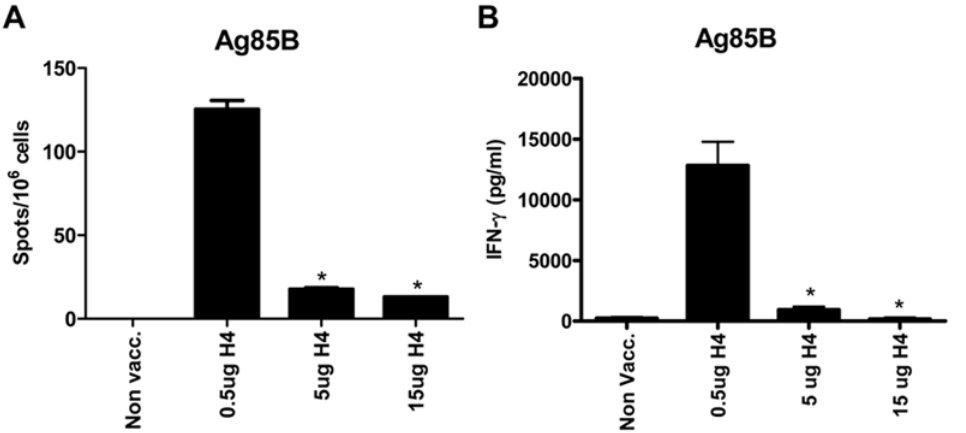
Figure 2. ELISPOT analysis of splenocytes from vaccinated animals. (A and B) Splenocytes isolated from groups of mice vaccinated with 3 different doses of Ag85B-TB10.4 in IC31 H or a saline control group (Non Vacc.) were stimulated in vitro with Ag85B for 48 hours and subjected to ELISPOT analysis (A) or stimulated for 72 hours to measure IFN- c cytokine secretion by ELISA (B). The bars represent means of 3 individual mice. SEMs are indicated. In both (A) and (B) a vaccination dose of 0.5 m g Ag85B-TB10.4 gave significantly (*p , 0.05, one-way ANOVA and Tukey’s post test) higher antigen responses, compared to vaccination doses of 5 and 15 m g.